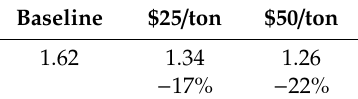
in the three scenarios. Percentages are relative deviations from the baseline scenario.